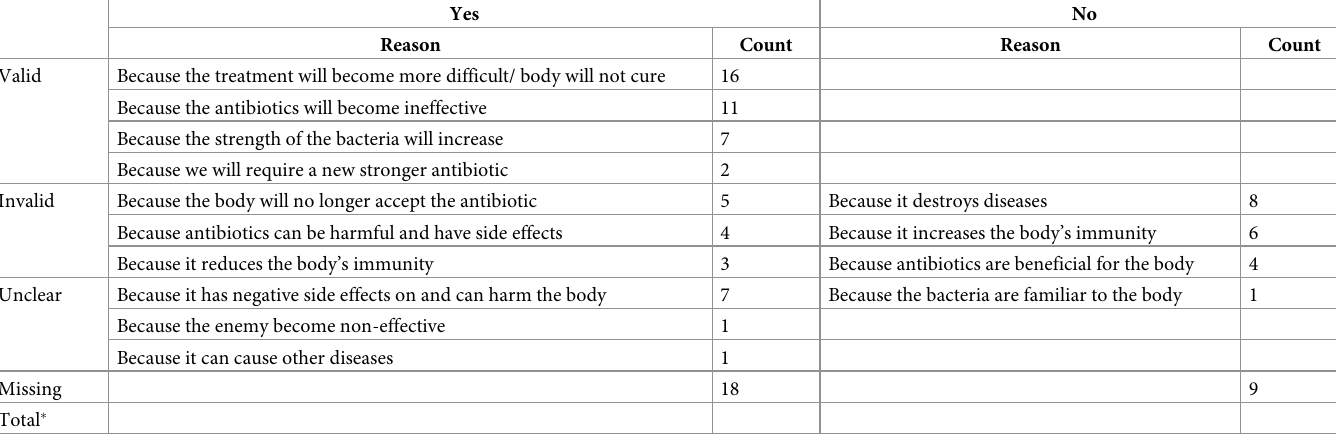
Table 10. Findings pertaining to Question 4: What is the impact of antibiotic resistance and is it a serious